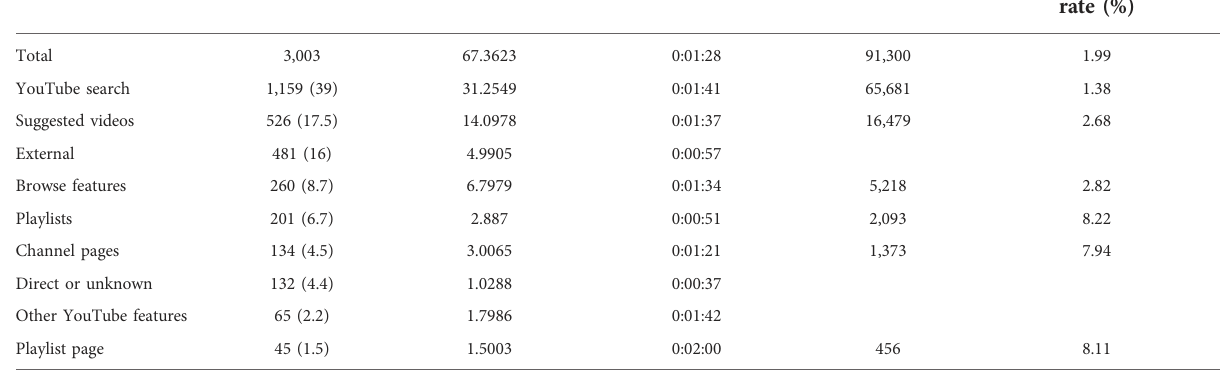
TABLE 2 Views and traf fi c sources for the REACT YouTube